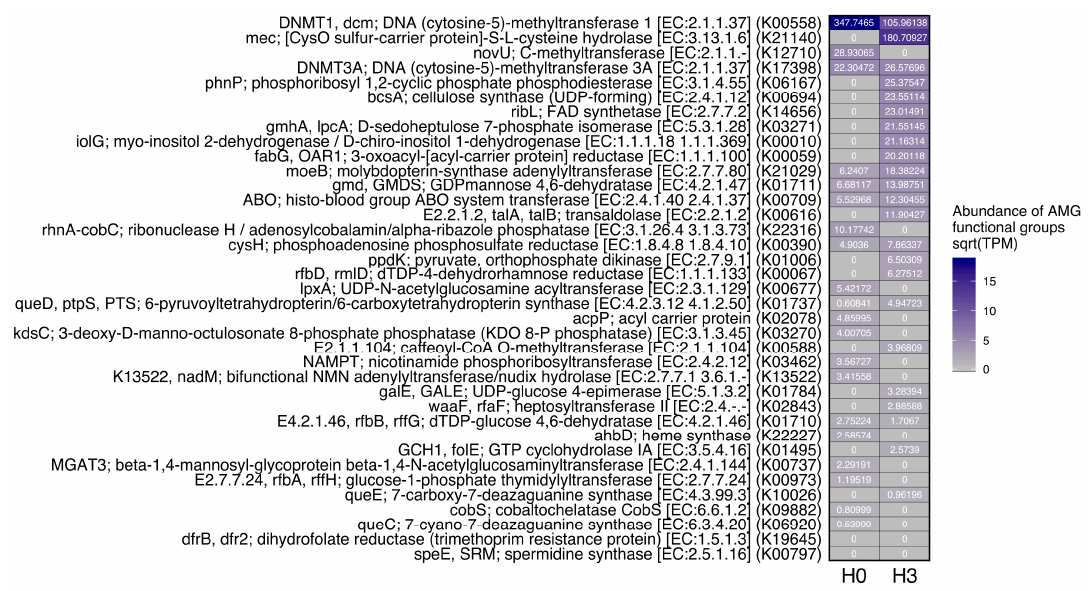
Figure 5. Viral auxiliary metabolic genes (AMGs) heatmap generated with VIBRANT.